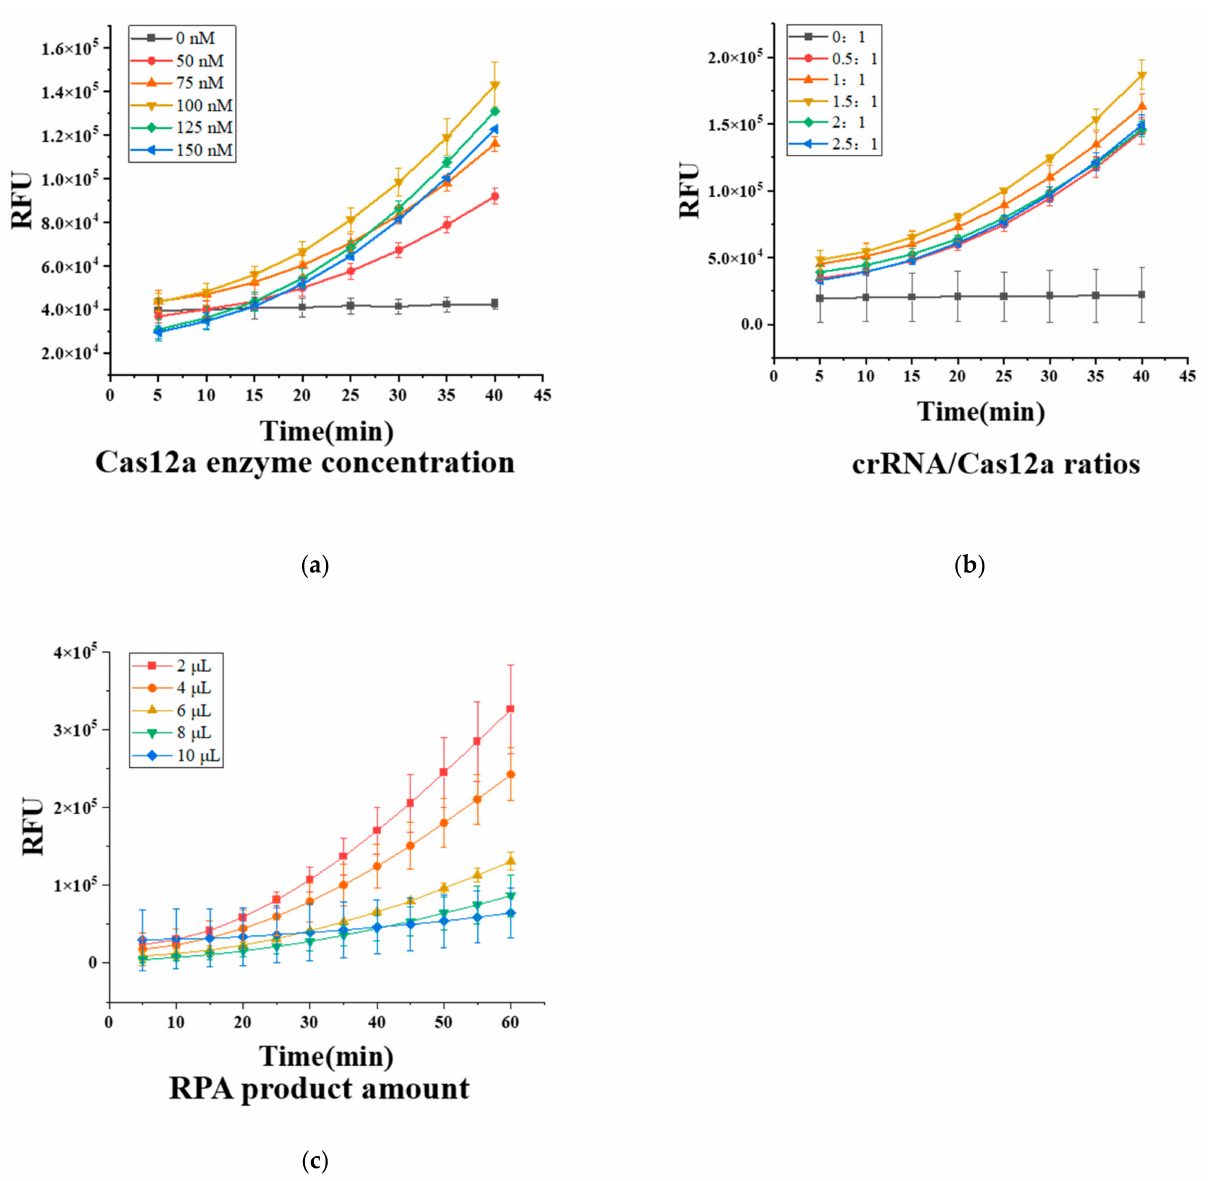
Figure 3. Optimization of RPA-CRISPR/Cas12a assay. ( a ) Cas12a enzyme concentration. ( b ) crR- NA/Cas12a ratios. ( c ) RPA product